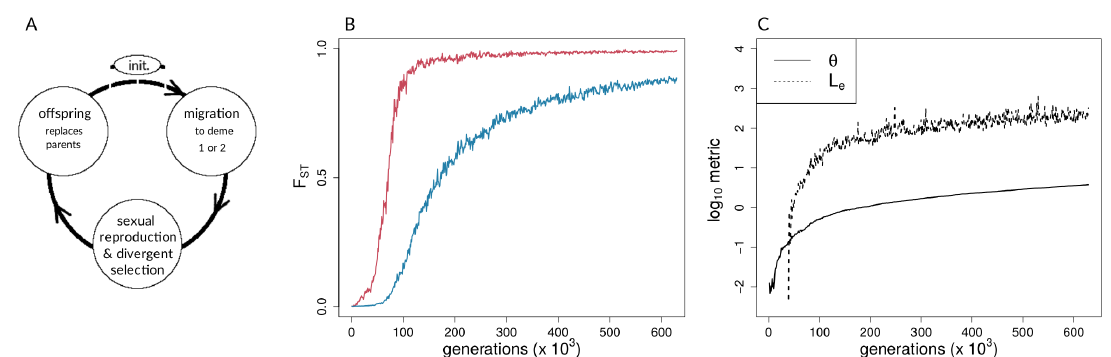
Figure 1. Forward-time simulations with ( A ) life-cycle diagram for the simulation model used, ( B ) population differentiation (fixation index, F ST ) over time for neutral (blue) and selected (red) sites, and ( C ) coupling measures for single simulation run. In ( B , C ), s = 0.005 and m = 0.01. The Methods section provides definitions of the coupling coefficient, θ , and the effective number of loci, L e .